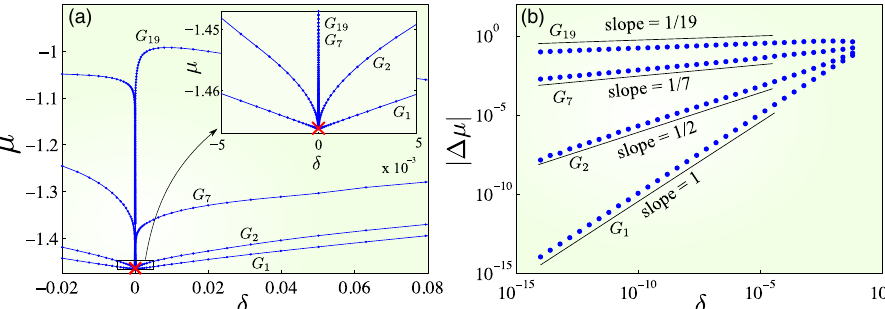
FIG. 9. Sensitivity to weighted perturbations in directed networks of optoelectronic oscillators. (a) Mean convergence rate μ as a function of δ , illustrating the qualitative difference between sensitive networks ( G 2 , G 7 , and G 19 from Fig. 7) and nonsensitive networks ( G 1 from Fig. 7). The red cross symbol indicates the value of μ at δ ¼ 0 corresponding to the case of no perturbation, which is the same for all four networks. The inset shows a zoom-in plot of the marked rectangular region surrounding the red cross. The perturbation matrix Δ A was chosen randomly following the same procedure used in Fig. 7. To facilitate visualization, in this figure we allow negative δ , which corresponds to considering a perturbation term of the form j δ jð − Δ A Þ . (b) Log-log plot of the change in convergence rate j Δ μ j versus δ , which confirms the scaling j Δ μ j ∼ δ 1 = β for small δ